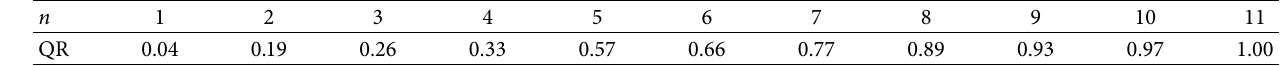
Table 1: Common criteria for evaluating similarity